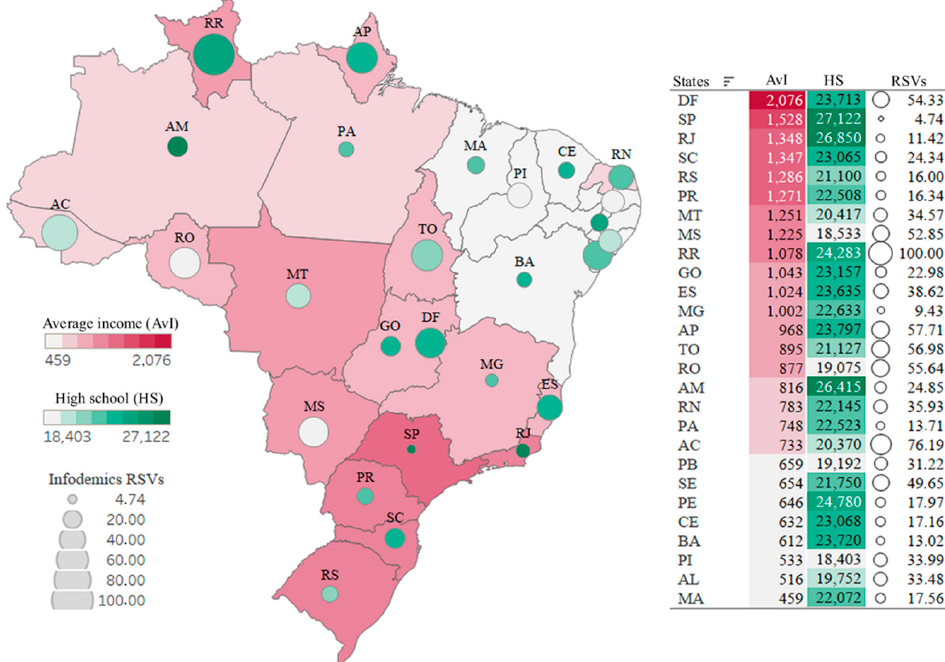
Figure 3. Spatial distribution: Infodemics RSVs, income, and education.